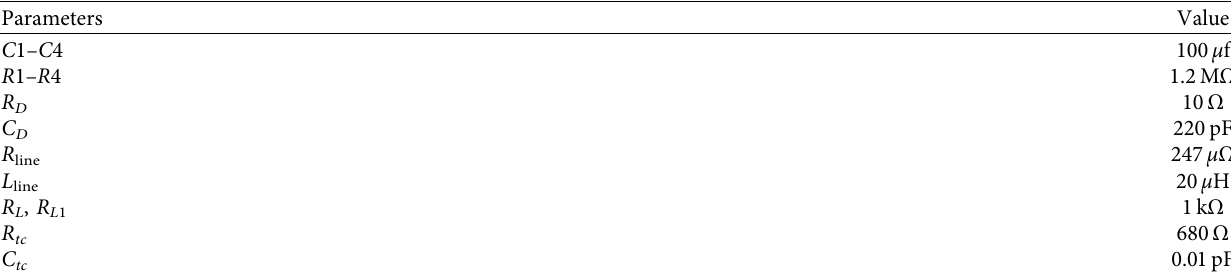
Figure 9: The effect of the RC-snubber circuit on (a) output pulse and (b) switching dynamics of MOSFET. Note that the stray inductance was set higher, i.e., 20 μ H. Table 3: Summary of the parameters used in the simulation study.